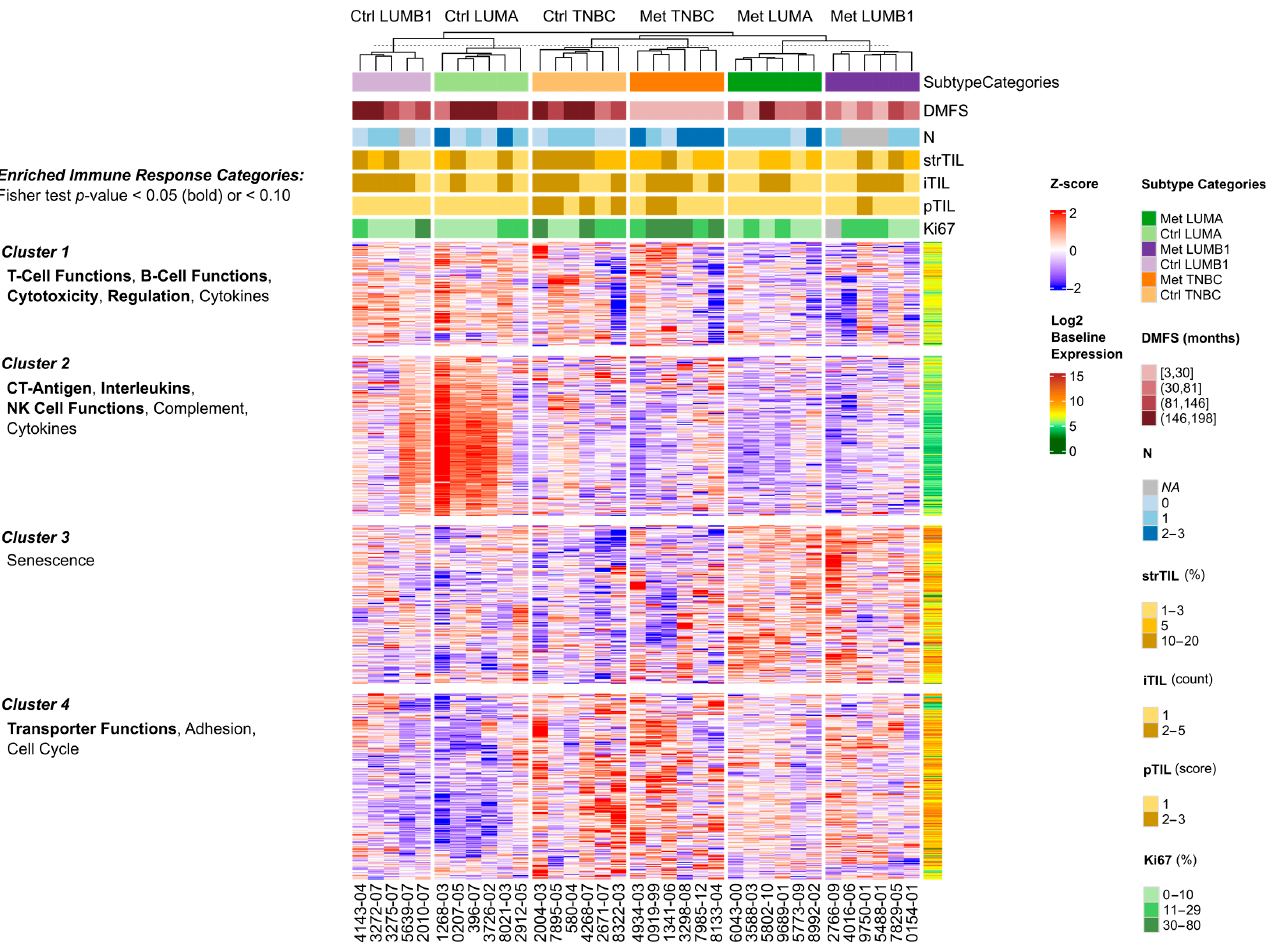
Figure 5. Unsupervised clustering of the 730 immune genes’ normalized expression: The samples ( n = 35) are grouped according to their subtype categories, and the four gene clusters are annotated with enriched immune response categories (one-sided Fisher’s exact test). The log2 baseline expression of the genes is shown on the right side of the